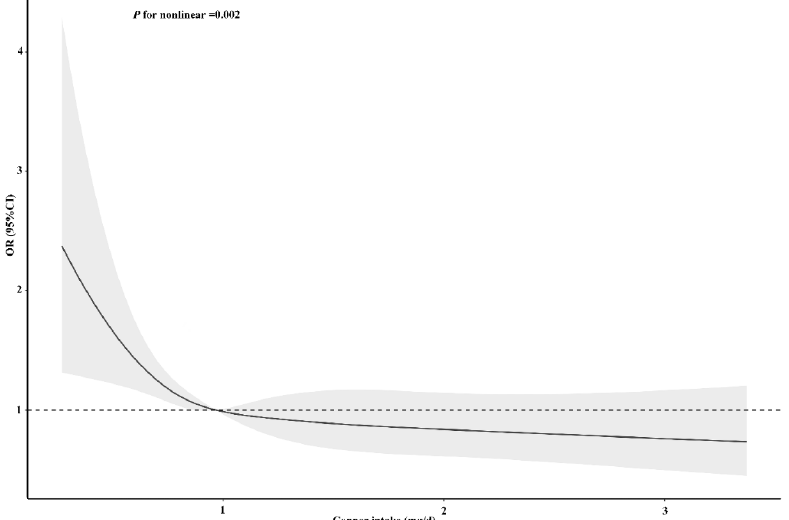
Figure 6. Restricted cubic spline models for the relationship between dietary copper intake and the risk of stroke after matching. The 95% CIs of the adjusted ORs are represented by the gray-shaded area. The model is adjusted for sex, age, race (Mexican American, other Hispanic, non-Hispanic white, non-Hispanic black, or other race), education (less than 9th grade, 9–11th grade, high school, graduate/GED or equivalent, some college or AA degree, or college graduate or above), PIR, marital status (married/living with partner, widow/divorced/separated, or never married), insurance,